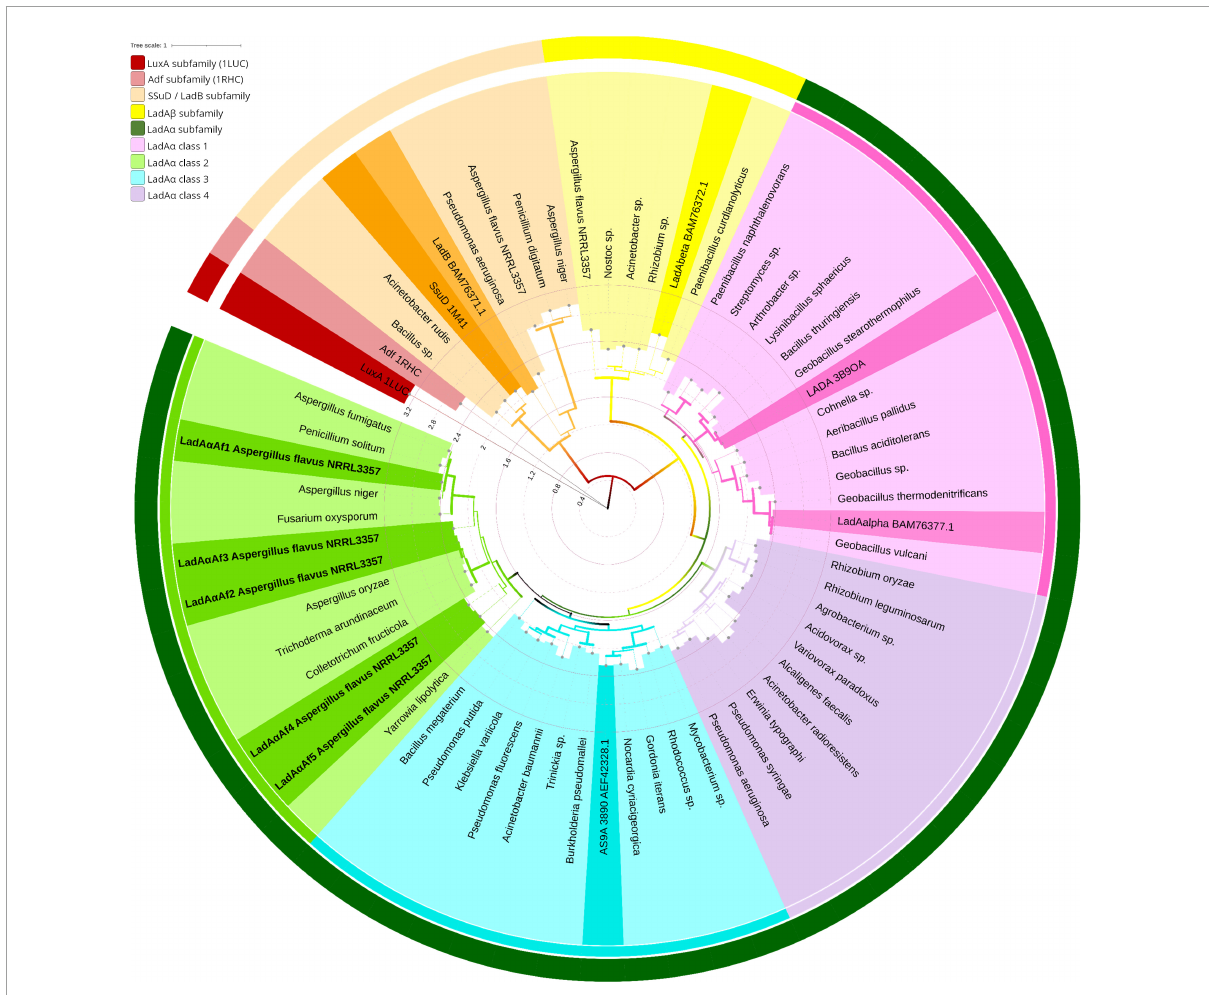
FIGURE1 Protein phylogeny of the LadA and LadB like FMN-dependent monooxygenases in bacteria and fungi. The evolutionary relationship was inferred by Maximum Likelihood method based on the LG substitution matrix (Le and Gascuel, 2008). The tree with highest log likelihood ( − 22645.26) is shown. The percentage of trees in which the associated taxa clustered together (1,000 bootstrap replications) is represented by the width of the branch. The tree is drawn to scale, with branch lengths measured in the number of substitutions per site (Internal tree scale). Leaves are colored according to their affiliation to clusters. Outer circle shows LadA α subfamily (dark green), LadA β subfamily (yellow), LadB/SsuD family (orange), Adf (light maroon), and LuxA (maroon). The inner circle shows four classes of LadA α subfamily: LadA α Class 3 (light green), LadA α Class 2 (blue), LadA α Class 4 (purple), LadA α Class 1 (pink). The structurally and functionally characterized LadAs, LadB B23 , and alkanesulfonate monooxygenase (SsuD) from Escherichia coli (Fisher et al., 1996; Eichhorn et al., 2002; Aufhammer et al., 2004; Li et al., 2008; Boonmak et al., 2014) are highlighted in each cluster. The tree was inferred by MEGA X (Kumar et al., 2018) and visualized using iTOL (Letunic and Bork, 2021) v6. GenBank accession numbers correspond to all leaf labels are shown in Supplementary Figure 2A